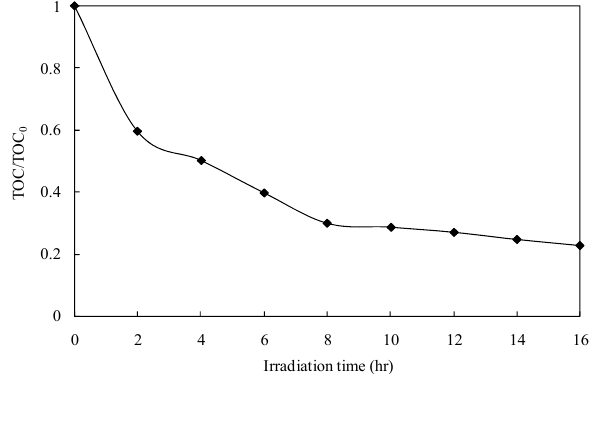
Figure 8. Depletion in total organic carbon (TOC) measured as a function of irradiation time for an aqueous solution of AO (0.1 g L − 1 ) in the presence of NaBiO